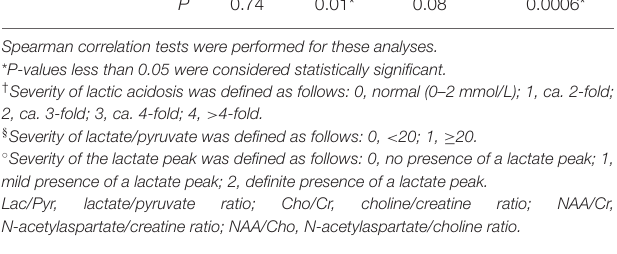
TABLE 3 | Correlation of serum biomarkers and magnetic resonance spectroscopy (MRS) parameters in regions with acute infarct ( n = 42). MRS Serum